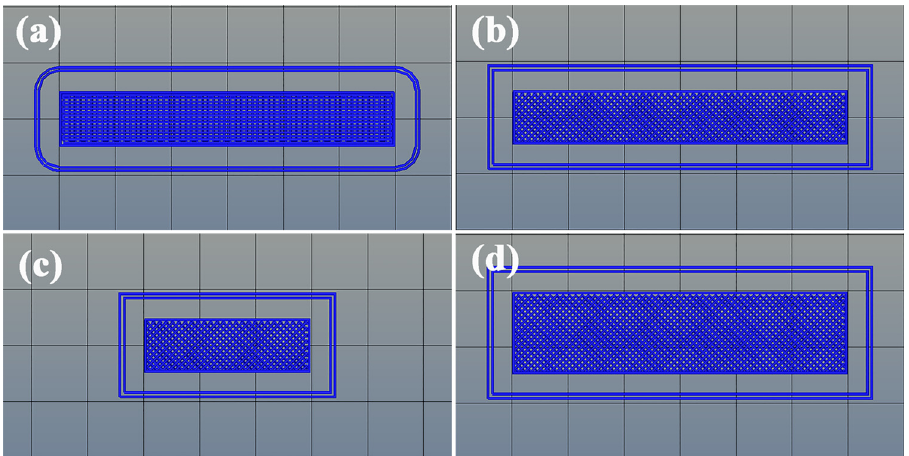
Figure 5: The 3D printing structure models of ( a ) 60 × 10 mm with 90°/0° con fi guration, ( b ) 60 × 10 mm with 45°/135° con fi guration, ( c ) 30 × 10 mm with 45°/135° con fi guration, and ( d ) 60 × 15 mm with 45°/135° con fi guration for intelligent PDMAA